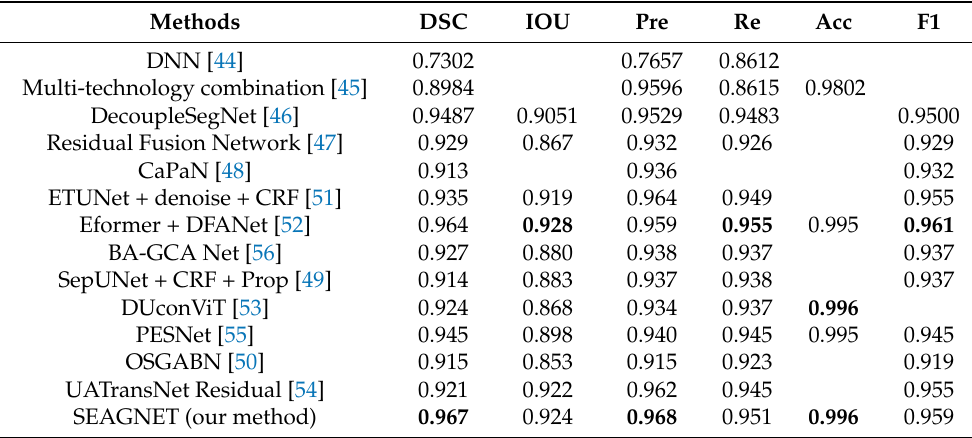
Table 2. Performance statistics of the proposed SEAGNET method compared with existing os- teosarcoma segmentation methods based on several metrics. The blanks indicate that the data was not